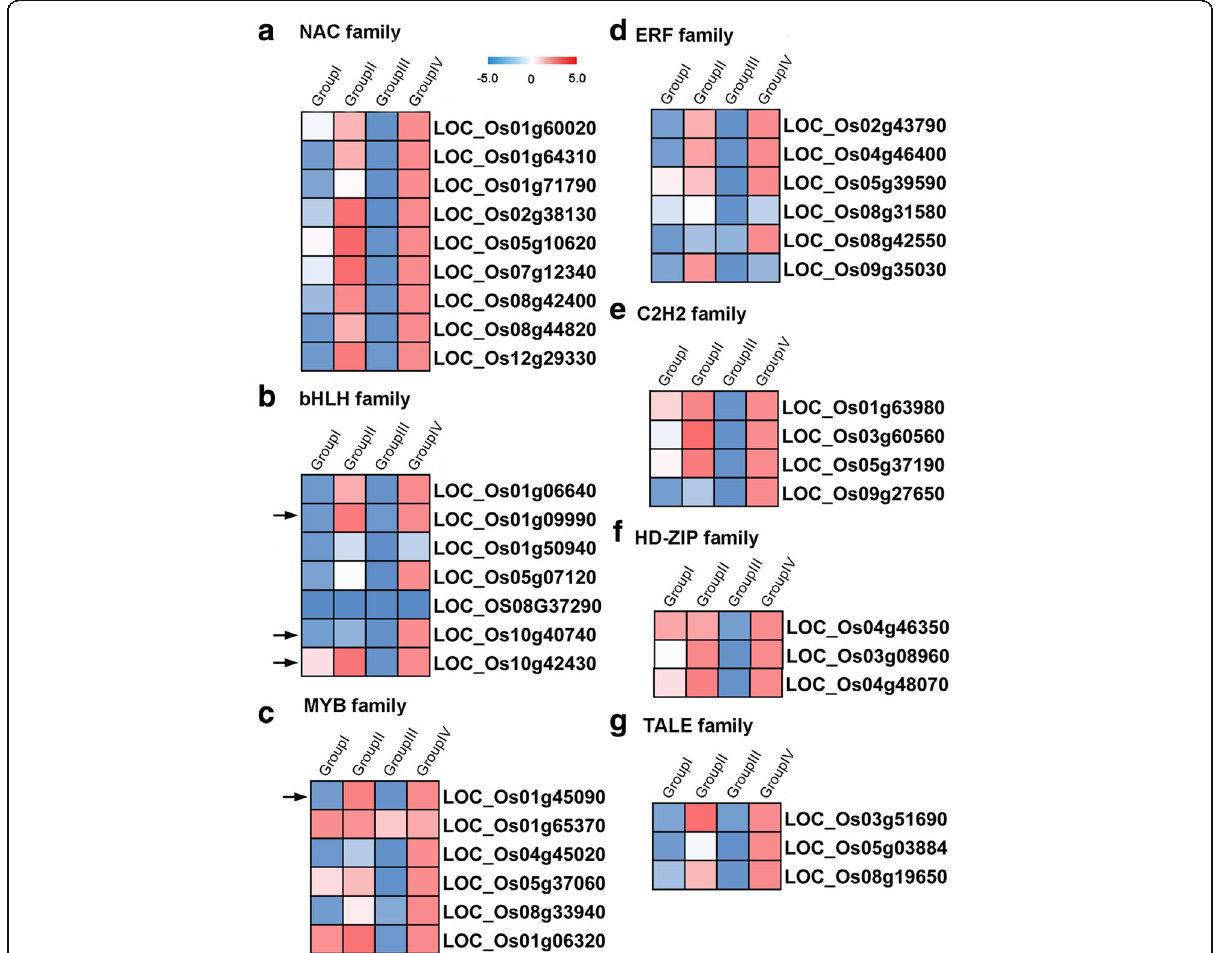
Fig. 8 Expression patterns of genes involved in transcription regulation in Group III ( SaSbSc vs Sc ). a Expression patterns of NAC family genes. b Expression patterns of bHLH family genes. c Expression patterns of MYB family genes. d Expression patterns of ERF family genes. e Expression patterns of C2H2 family genes. f Expression patterns of HD-ZIP family genes. g Expression patterns of TALE family